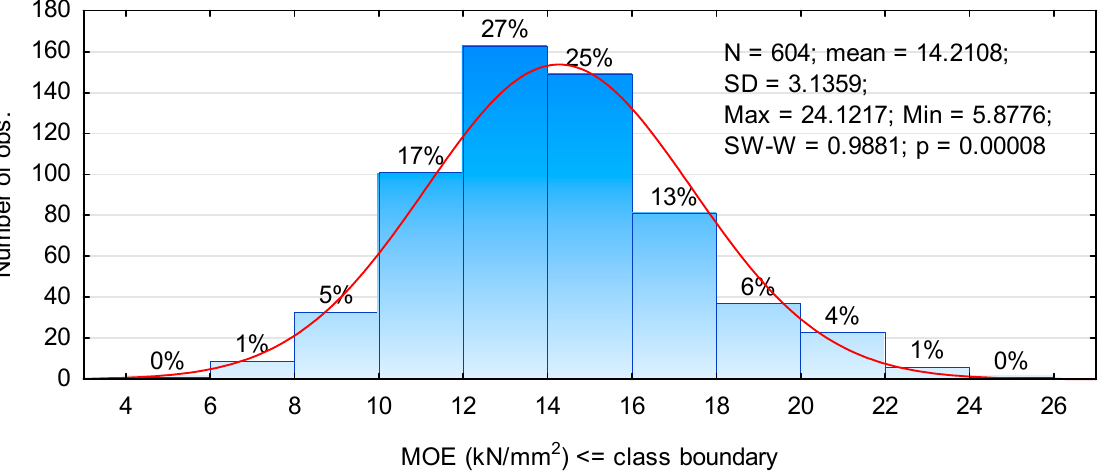
Figure 4. Histogram for the distribution of the modulus of elasticity.